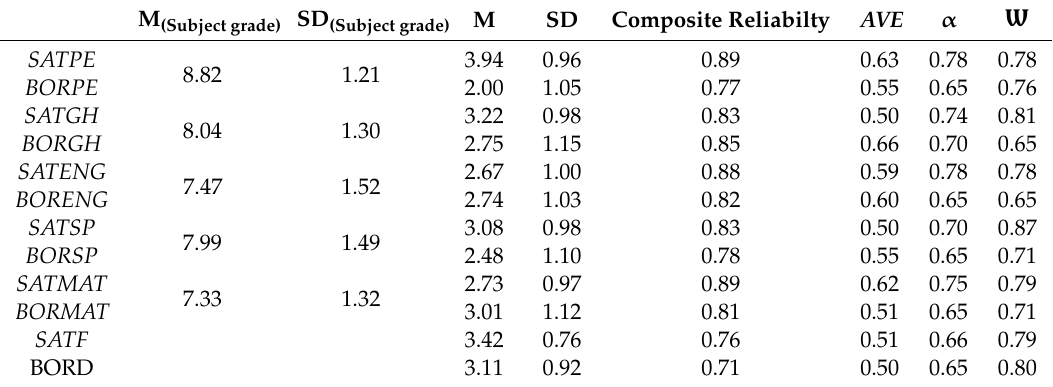
Table 3. Scale of reliability and composite validity.